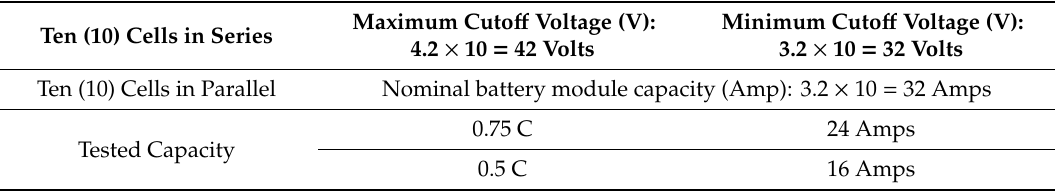
Table 2. Battery Module Specification.